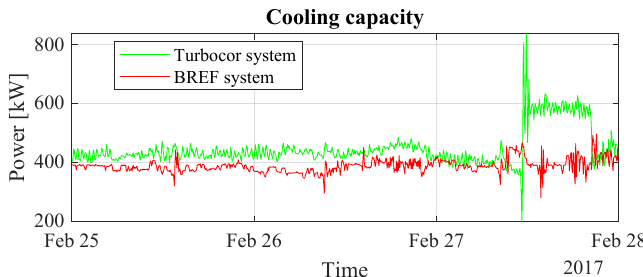
Figure 20. Cooling capacity on 25–27 February 2017.